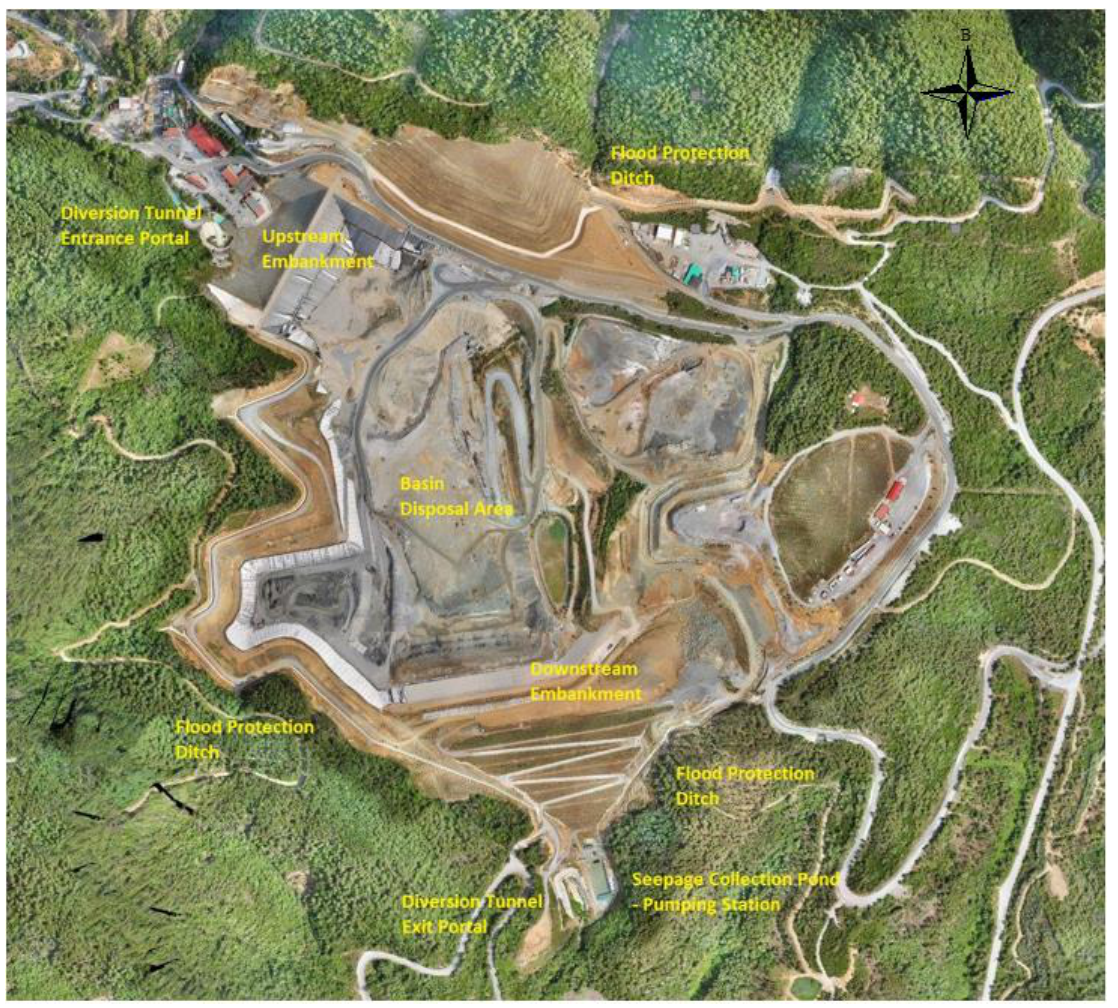
Figure 1. Kokkinolakas Tailings Management Facility plan view.